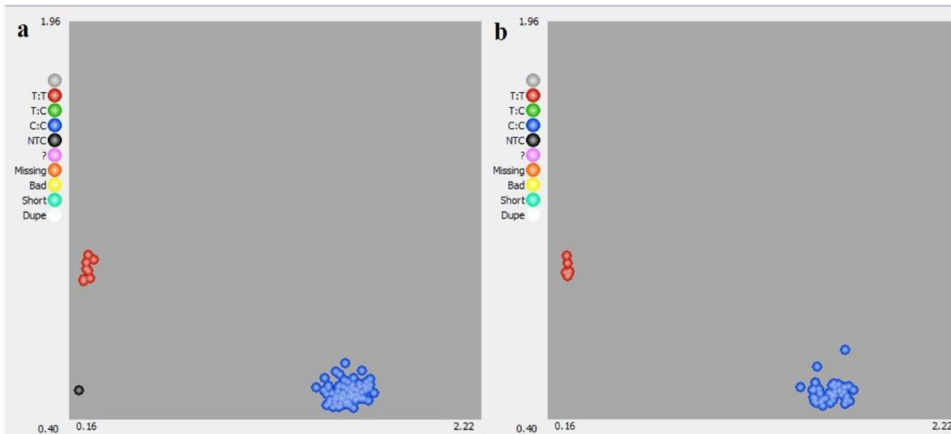
Figure 3. Genotype plot for KBoHL2 generated using the KASP assay. T/T (Red dots), genotypic results for 11 BoHL2 lines; C/C (Blue dots), genotypic results for normal lines; black dots indicate negative controls. ( a ), Genotype plot for 1–100 lines by KBoHL2, ( b ), Genotype plot for 101–138 lines by